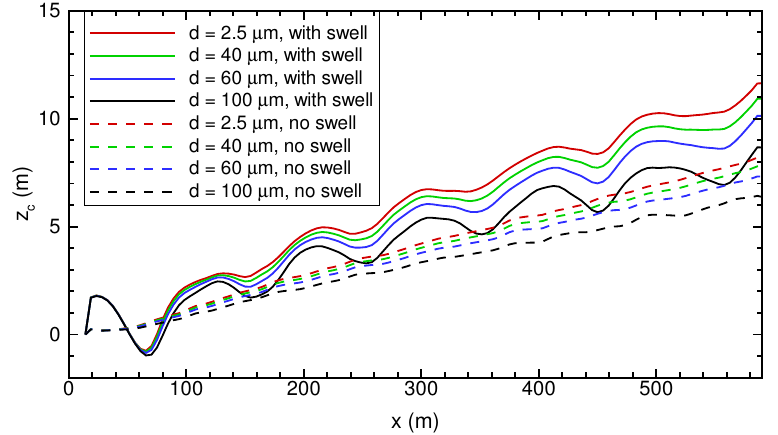
Figure 10. Center-of-mass height z c of oil aerosols as a function of the streamwise location. The solid lines are for the plane-progressive wave case, and the dashed lines are for the flat-surface benchmark